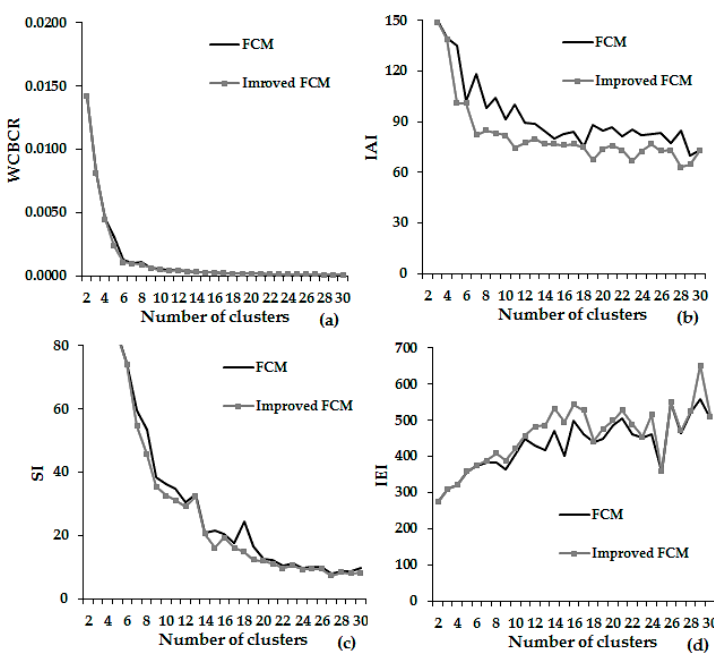
Figure 4. Comparison of the algorithms considering: ( a ) WCBCR, ( b ) IAI, ( c ) SI and ( d ) IEI indicators on the 2011 data set of consumer 1.